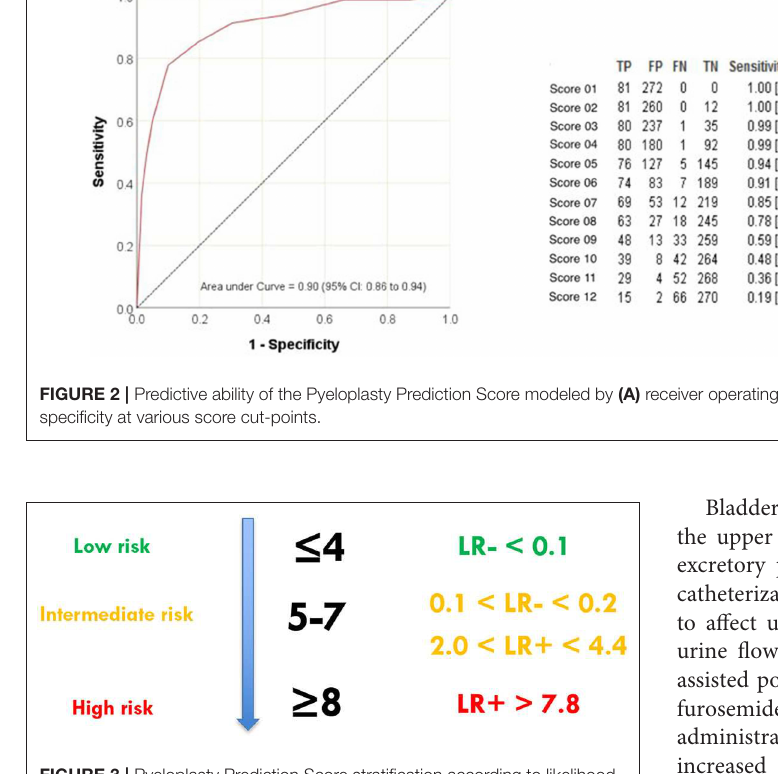
FIGURE 3 | Pyeloplasty Prediction Score stratification according to likelihood